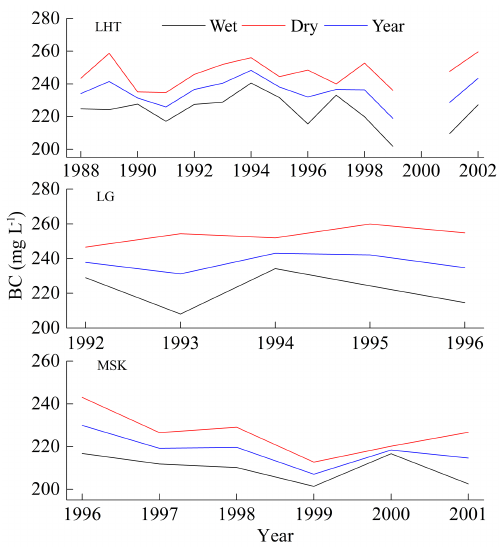
Figure 6. Variation in net carbon discharge among sites in the wet season, dry season, and whole year during the study period.